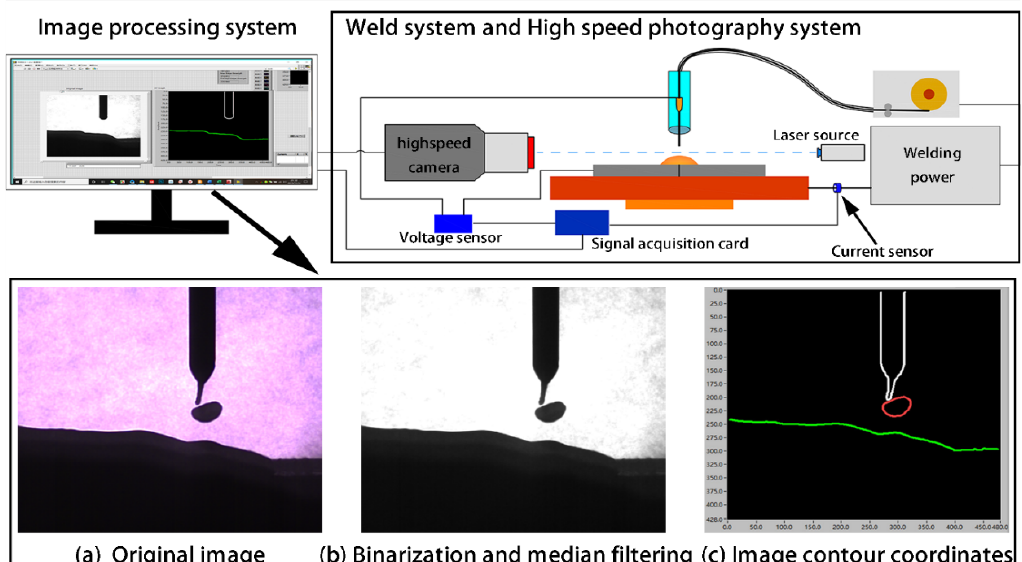
Figure 1. Experimental system and image processing system.